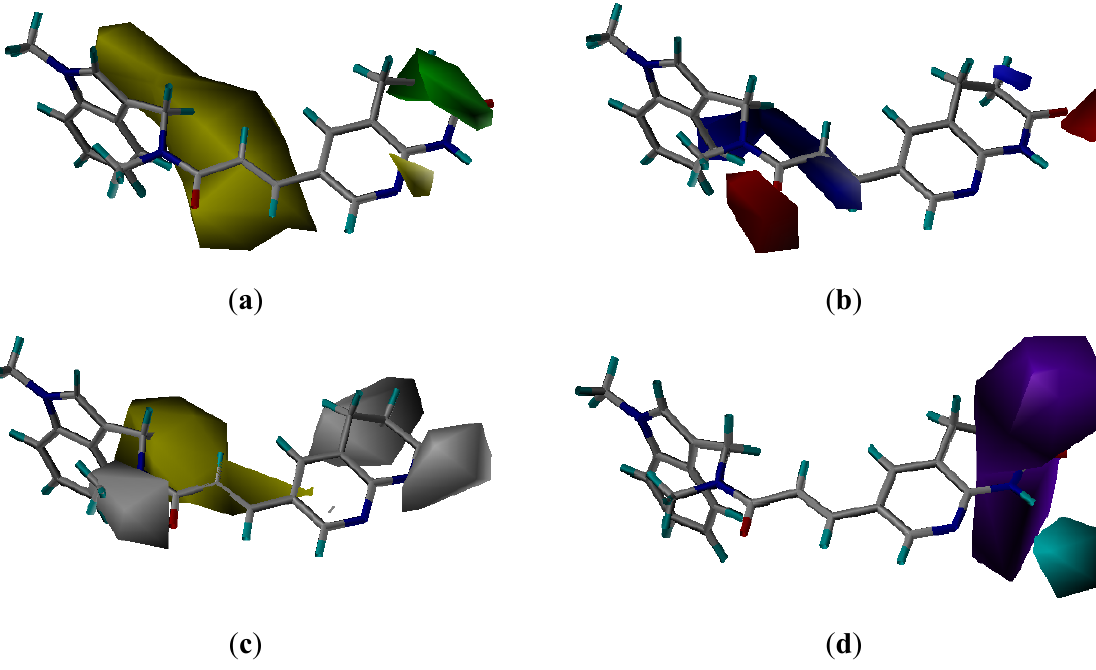
Figure 5. CoMSIA contour maps from the pharmacophore-based alignment. ( a ) CoMSIA steric and electrostatic contour map. Green and yellow represent sterically favored and disfavored regions, respectively. ( b ) CoMSIA electrostatic contour map. Blue and red represent electrically favored and disfavored regions, respectively. ( c ) CoMSIA hydrophobic field contour map. Yellow regions indicate where hydrophobic groups increased activity and white regions indicate areas where hydrophilic groups increased activity. ( d ) CoMSIA H-bond donor contour map. Cyan contour indicates regions where hydrogen bond donor groups increased activity. Purple is disfavored. Compound 20 is shown inside the